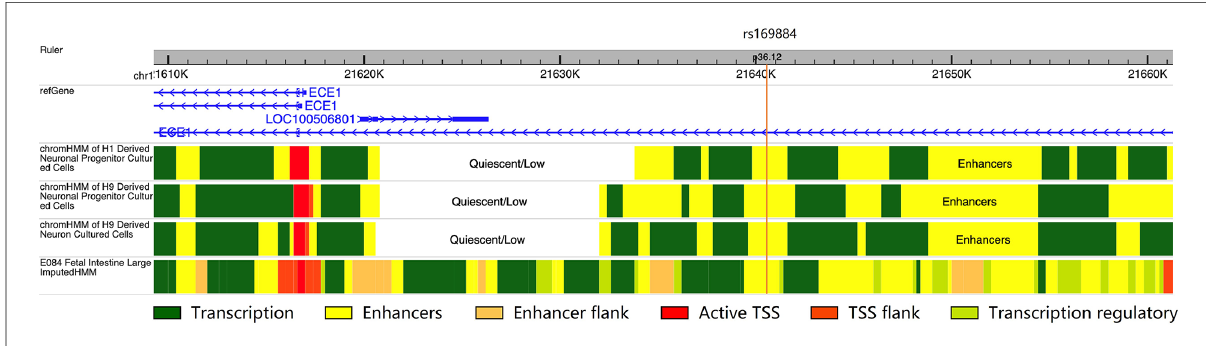
FIGURE 1 The chromatin states of the genomic region surrounding rs169884. The chromatin states were obtained from H1 or H9 derived neuronal progenitors, H9 derived neurons as well fetal large intestine. The genomic region nearby rs169884, which belongs to the ECE1 intron, was enriched with enhancer signals across the selected cell types or tissue. The genomic version was hg19.